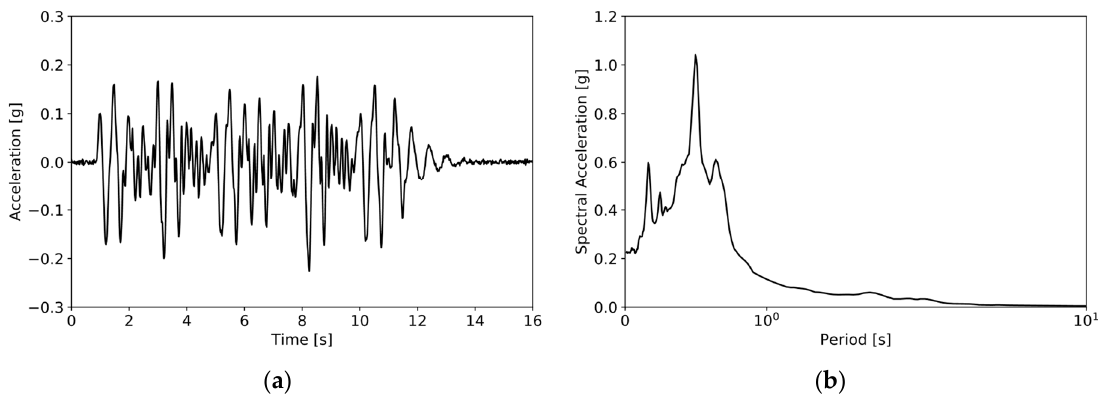
Figure 8. ( a ) Lateral acceleration at the base of the laminar box of VELACS model 2 (Elgamal et al.